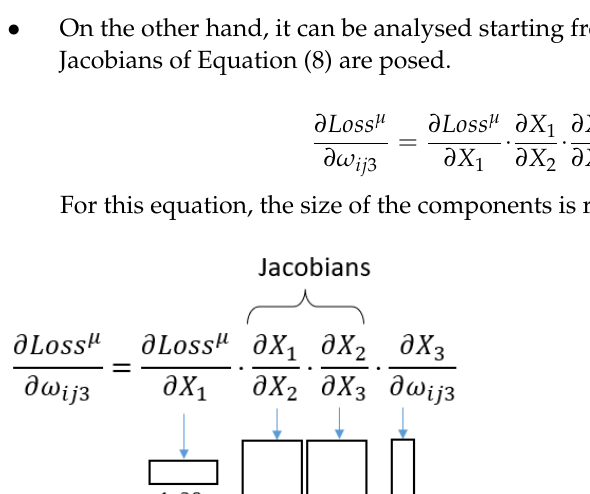
Figure 4. Jacobians and their sizes, taking the network from the input layer .